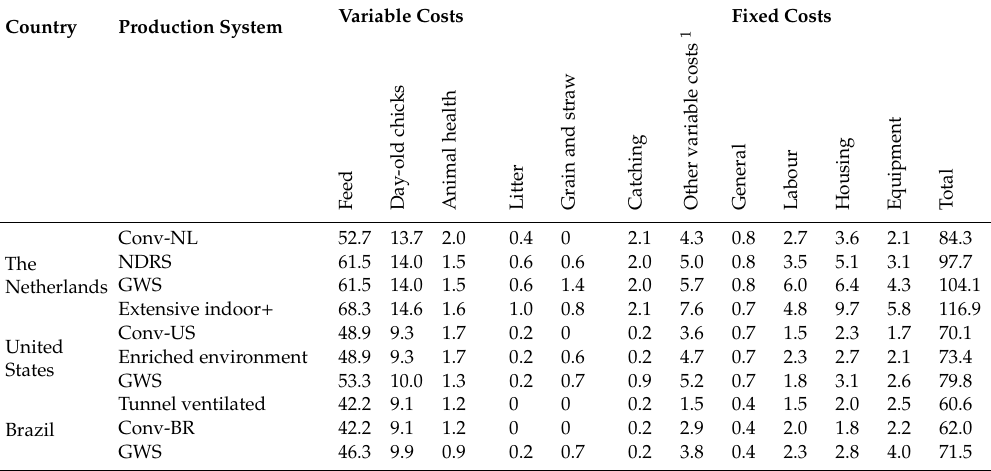
Table A2. Breakdown of production costs per cost component (in eurocents per kg live